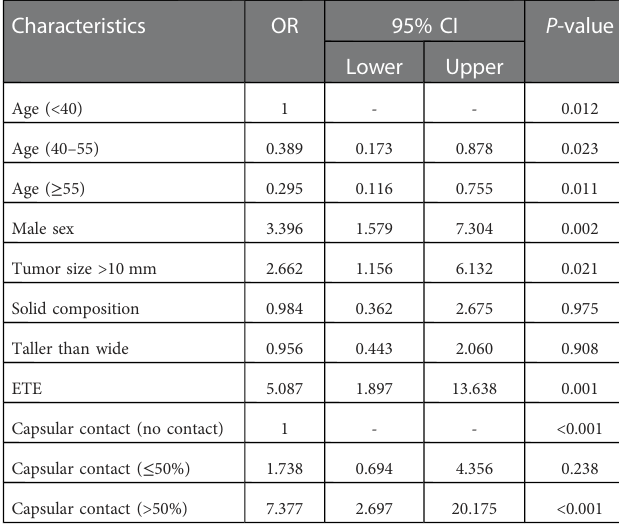
TABLE 3 Multivariate analysis of risk factors for HVLNM. TABLE 2 Univariate analysis of risk factors for HVLNM in the training